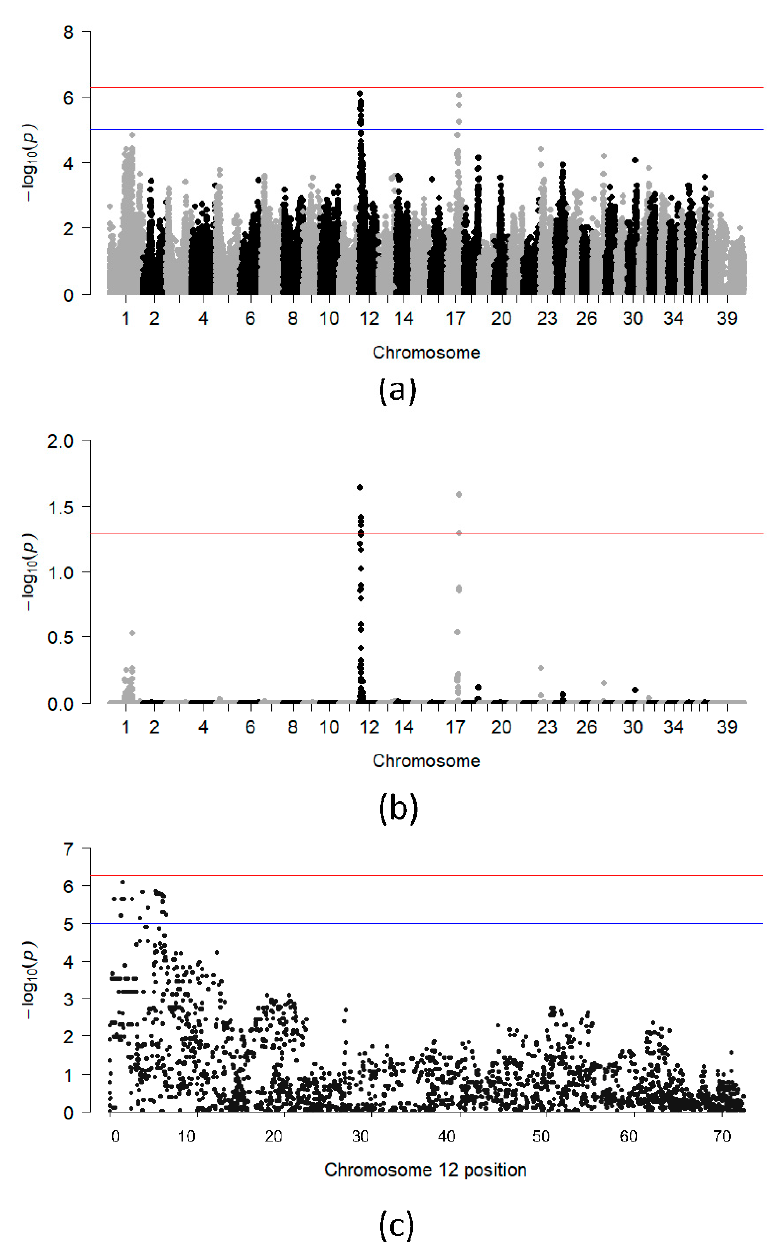
Figure 1. Chi-square based allelic association ( a ) and association test after 100,000 permutations ( b ) for the entire dataset. ( c ) Plot showing − log 10 of the raw p-values for each SNP on CFA 12. The blue and red lines indicate suggestive ( − log 10 [ p -value] ≥ 5) and Bonferroni-adjusted genome-wide significance threshold ( − log 10 [ p -value] ≥ 6.3), respectively.